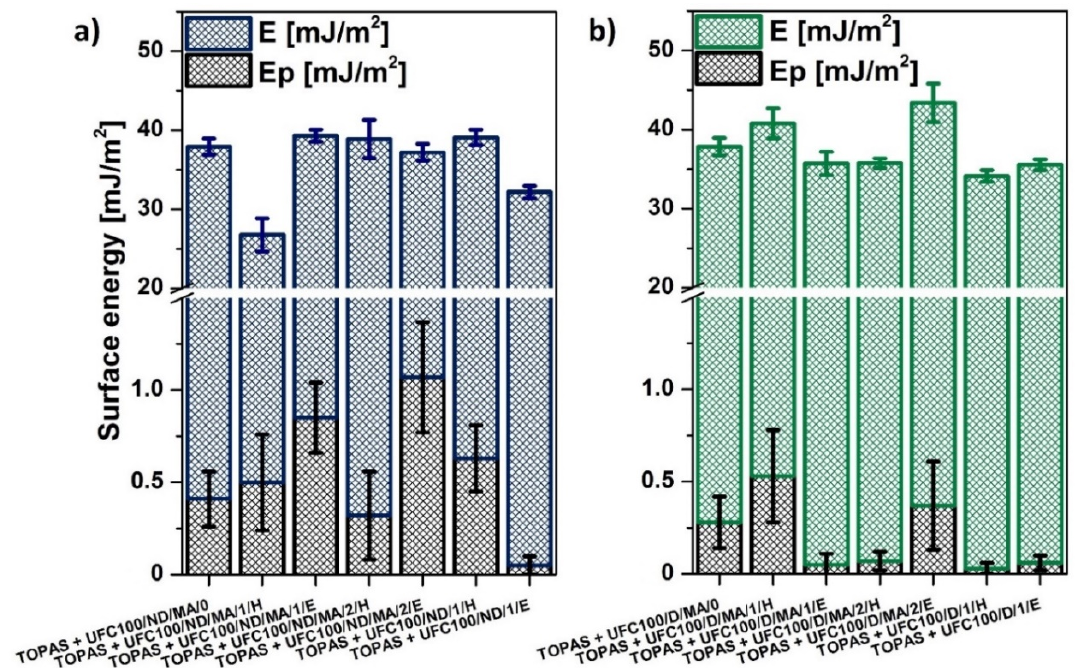
Figure 7. Surface free energy of investigated blends filled with modified cellulose fibers: ( a ) not dried before the modification process; ( b ) dried before the modification process.